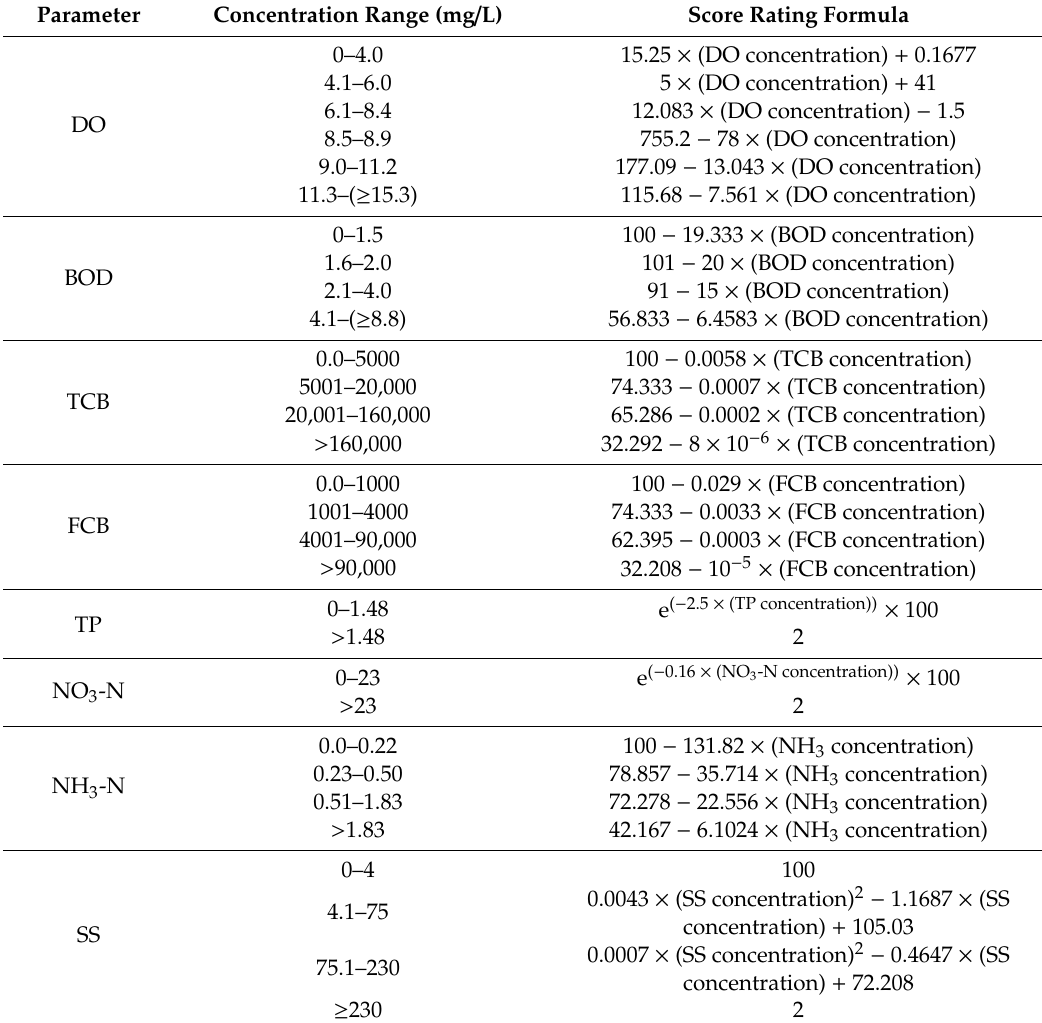
Table A1. Rating formulas of eight parameters for score converting in